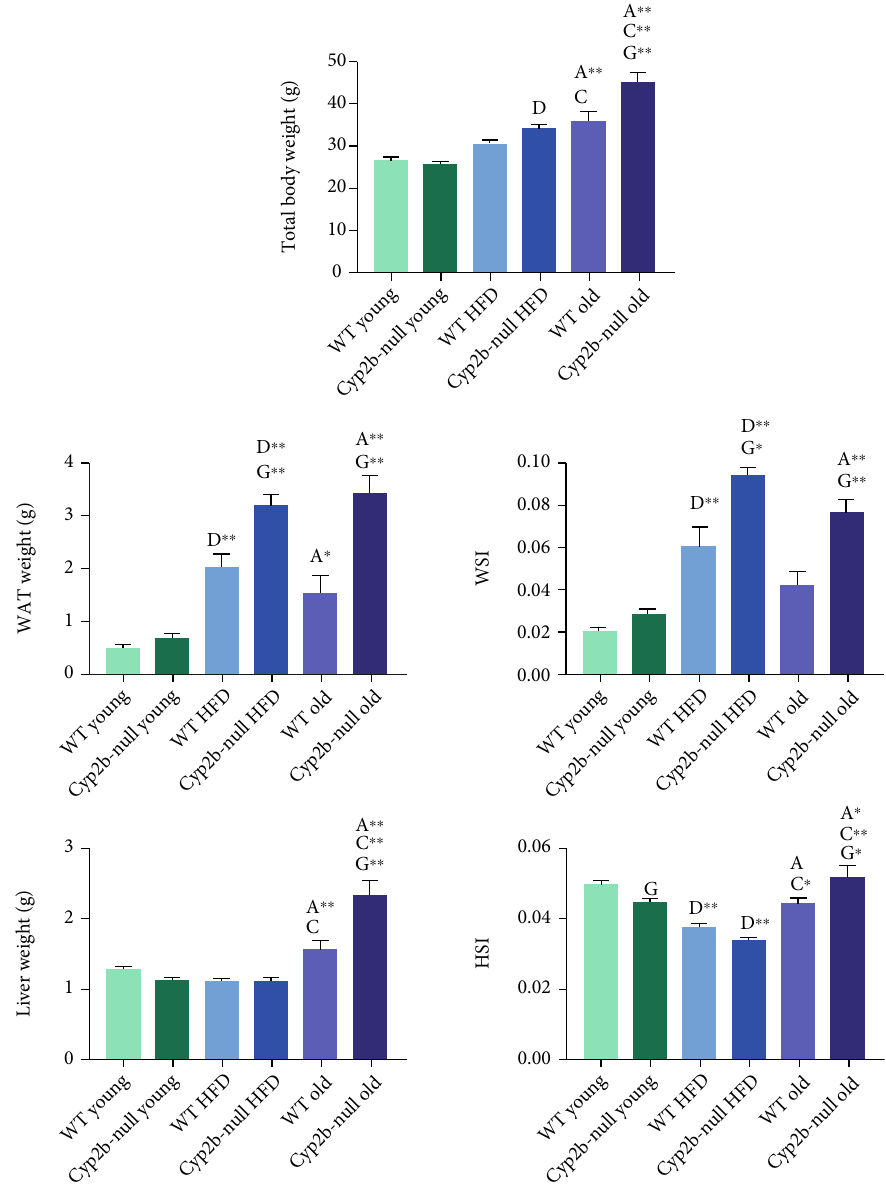
Figure 1: Comparison of total body, liver, and WAT weights between all treatment groups. Total body weight, liver weight, hepatic somatic index (HSI), WAT weight, and WAT somatic index (WSI) were measured for all treatment groups. Data are presented as mean ð g Þ ± SEM . Statistical signi fi cance was determined by one-way ANOVA multiple comparison test with Tukey ’ s multiple comparison test as the post hoc test ( n = 5 − 9 ). “ a ” (age) indicates age di ff erence between young (4.5 mo) and old (9 mo) mice within the same genotype and diet group, “ c ” (catch) indicates di ff erence between HFD-fed young (4.5 mo) and ND-fed old (9 mo) mice within same genotype, “ d ” (diet) indicates diet di ff erence between ND-fed and HFD-fed mice within in same genotype and age, and “ g ” (genotype) indicates genotype di ff erence between WT and Cyp2b-null mice within same diet and age group. No asterisk indicates a p value < 0.05, ∗ indicates a p value < 0.01, and ∗∗ indicates a p values <